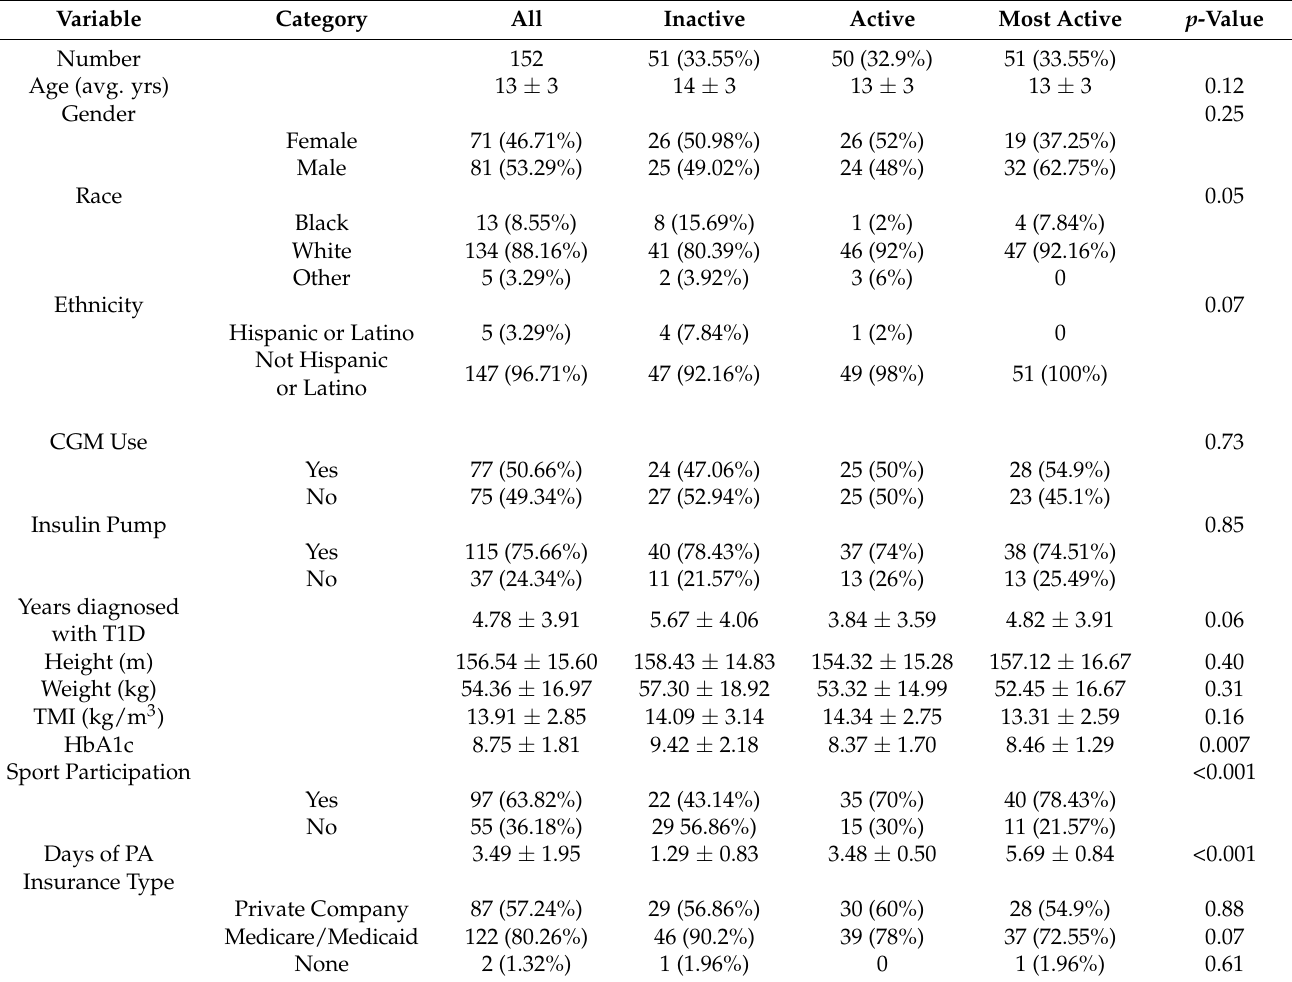
Table 1. Demographic characteristics and diabetes treatment measures for all participants and ANOVA results separated by physical activity